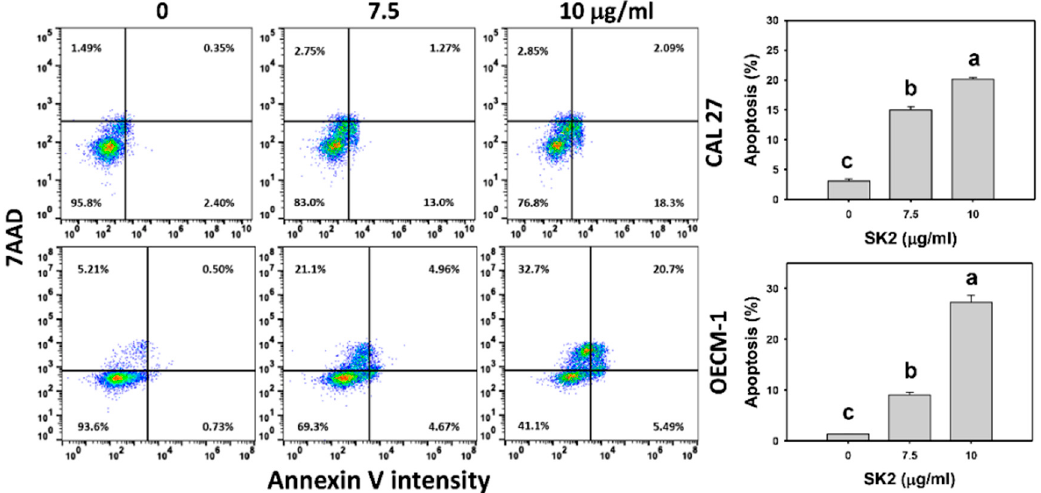
Figure 3. SK2 triggers apoptosis in oral cancer cells. Annexin V/7AAD detections and statistics are provided. Cells were exposed to SK2 (0 (0.1% DMSO), 7.5, and 10 µg/mL) for 24 h. Annexin V(+)/7AAD (+ or − ) was regarded as the apoptosis %. Data (means ± SDs; n = 3) without overlapping characters differed significantly ( p < 0.05). For an example of CAL 27 and OECM-1 cells, different concentrations with different characters produced significantly different results. For CAL 27 and OECM-1 cells, for SK2 at 0, 7.5, and 10 µg/mL, “c, b, and a” indicate significant differences because the data did not overlap.